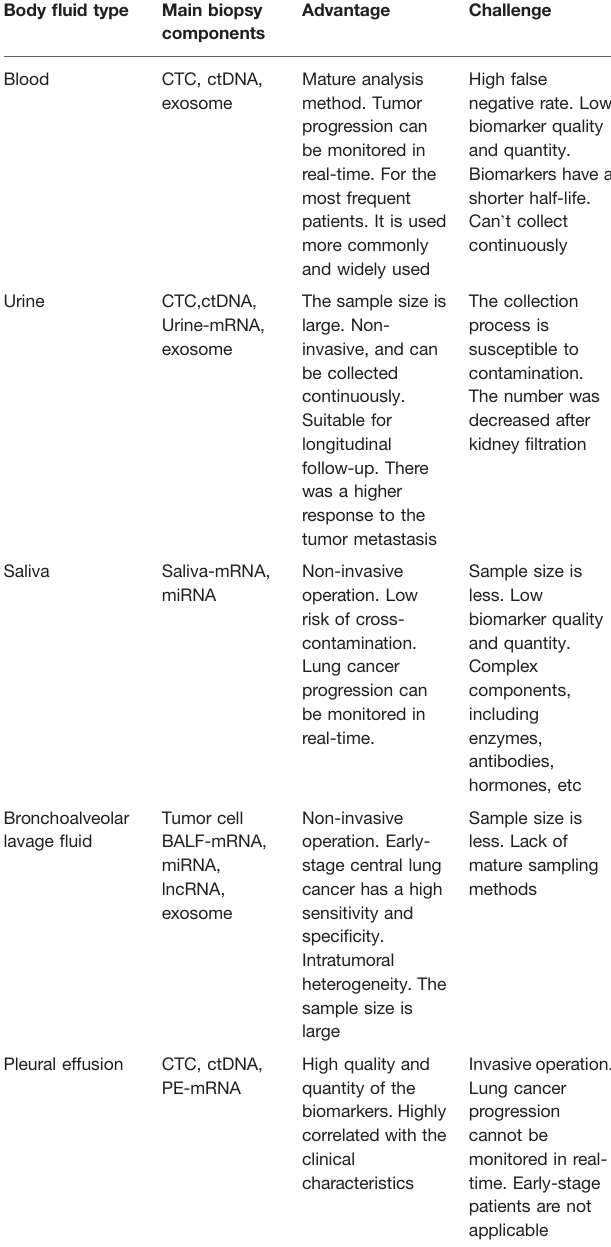
TABLE 2 | Comparison of different body fl uid